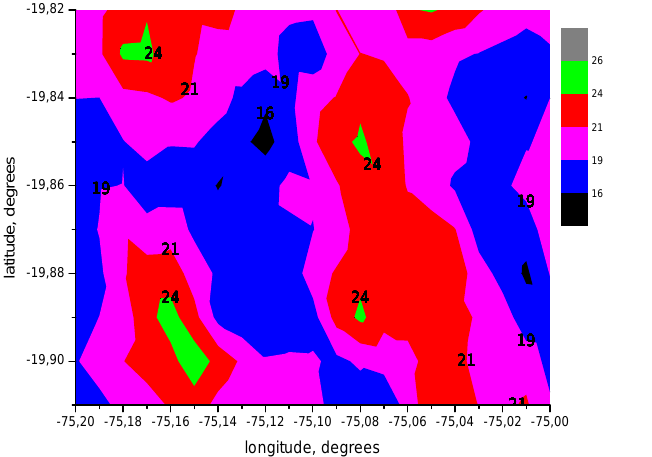
Fig. 8. The map of the effective radius retrieved using PEROMT at the cloud top (a) , middle (b) , and bottom (c) .